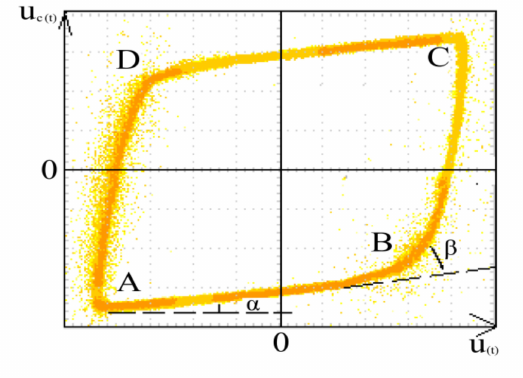
Figure 6. V-Q Lissajous graph.